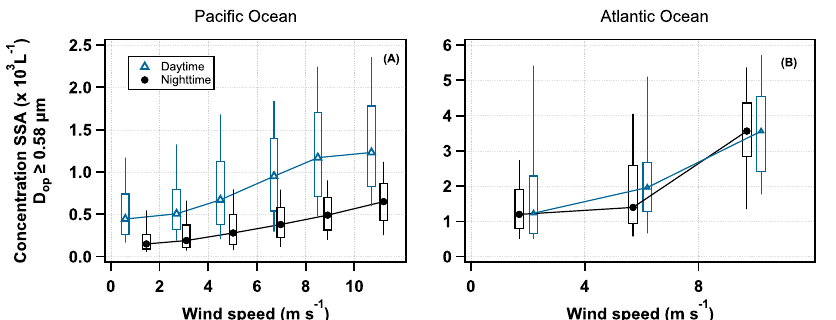
Fig. 4 Dependence of the sea spray aerosol number concentration with optical diameters ( D op ) ≥ 0.58 μ m (N SSA ≥ 0.58 µ m ) on wind speed. Box plots of the N SSA ≥ 0.58 µ m vs. wind speed, binned at 2 ms − 1 for the Paci fi c Ocean ( A ) and by 4 ms − 1 for the Atlantic Ocean ( B ) where data collected further than 100 km away from land was used. The day and night data are offset for clarity. The y -axis scale is different for the two panels. While the expected increase of aerosol concentration with wind speed is indeed observed, no relation between the 24-h cycle and wind speed is found. The box plots show the median, and the 10th, 25th, 75th, and 90th percentiles. For the daytime (nighttime) Paci fi c Ocean, N = 3612 (4057), 11,638 (14,833), 20,134 (19,506), 19,988 (23,136), 15,701 (16,097), and 8129 (9034) samples where used for the 0 – 2, 2 – 4, 4 – 6, 6 – 8, 8 – 10, and >10 m s − 1 bins, respectively. For the daytime (nighttime) Atlantic Ocean, N = 1089 (949), 4768 (5056), and 1082 (1707) samples were used for the 0 – 4, 4 – 8, and >8 m s − 1 bins,